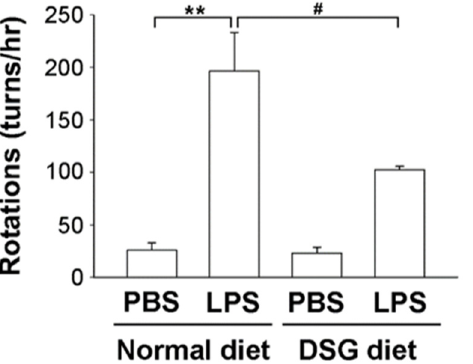
Figure 4. Effects of diosgenin on the amphetamine-induced rotational behavior of a rat model of LPS-induced Parkinson’s disease. Male SD rats were fed diets with or without 0.1% diosgenin ( w / w ) for 4 weeks before LPS or PBS was unilaterally injected into the right substantia nigra (SN). After the injection, rats were fed for 4 weeks and then tested for amphetamine-induced rotational behavior. The number of turns induced by amphetamine was recorded for 60 min. The results are presented as the means ± SD obtained from 3 different rats in independent experiments. ** p < 0.01 compared with control rats; # p < 0.05 compared with LPS-treated rats.